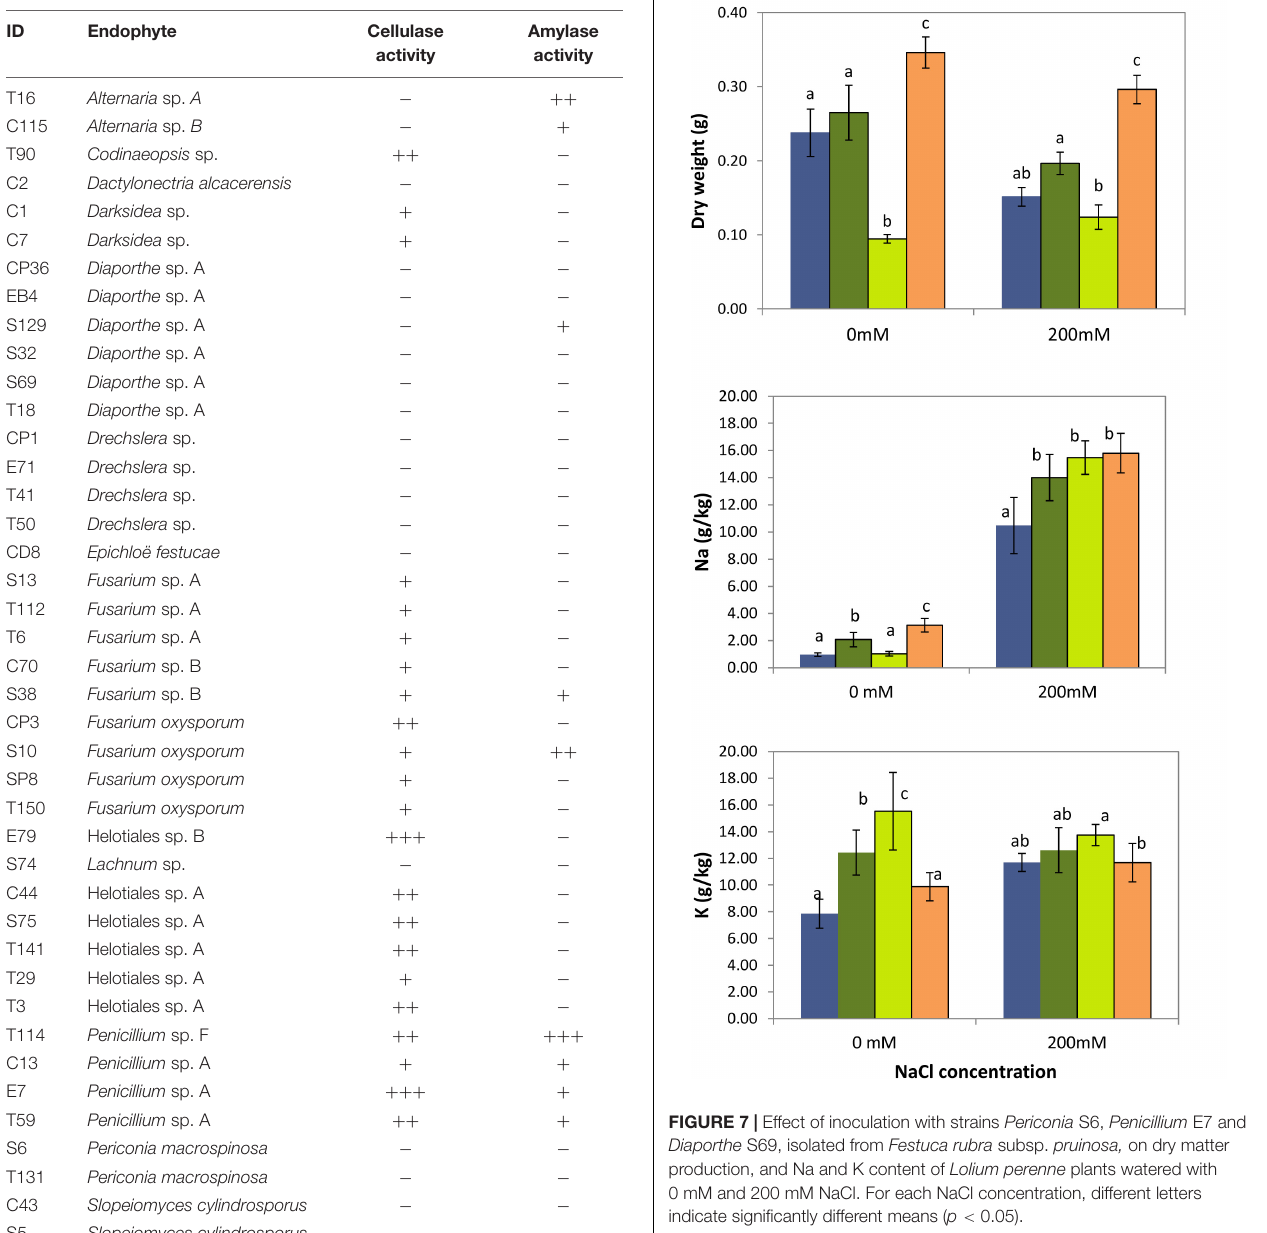
TABLE 6 | Cellulase and amylase activity in fungal strains isolated from roots Festuca rubra subsp. pruinosa plants from marine cliffs.